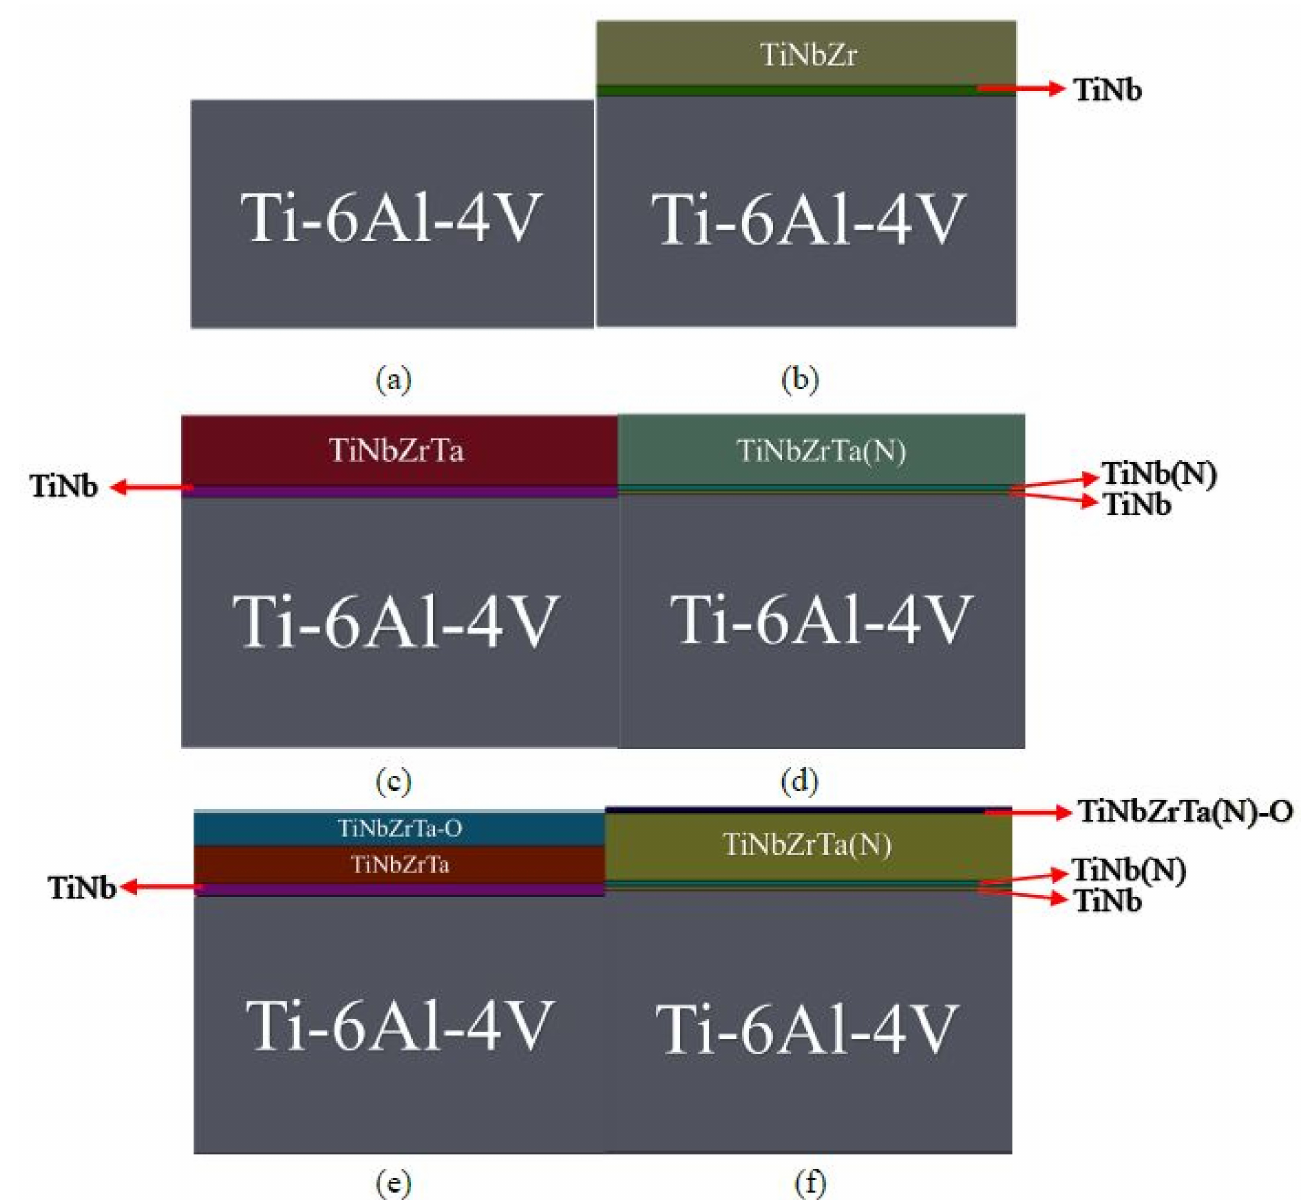
Figure 1. Diagram of the coating structure of ( a ) control Ti-6Al-4V (without coating); ( b ) TiNbZr; ( c ) TiNbZrTa; ( d ) TiNbZrTa(N); ( e ) TiNbZrTa-O; ( f ) TiNbZrTa(N)-O. ( b – f ) all the coatings are de- posited on the same material,